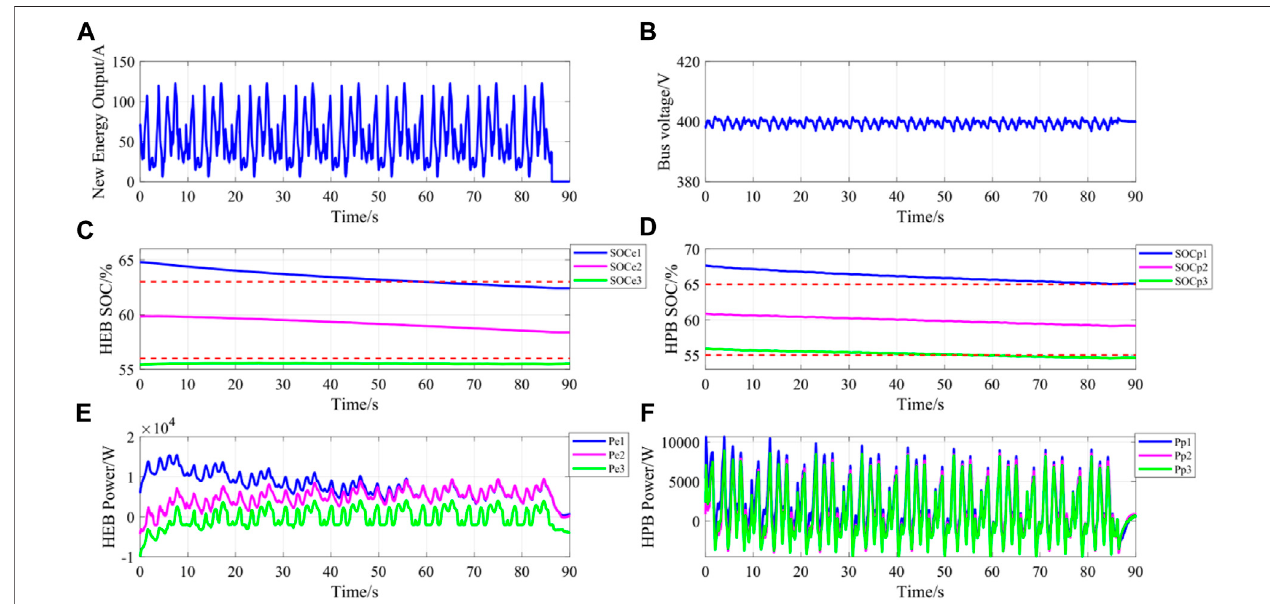
FIGURE 16 | Experimental results of DC microgrid in renewable energy generation: (A) Renewable energy output; (B) Bus voltage; (C) High-Energy Battery SOC; (D) High-Power Battery SOC; (E) Output power of High-Energy Battery; (F) Output power of High-Power Battery).